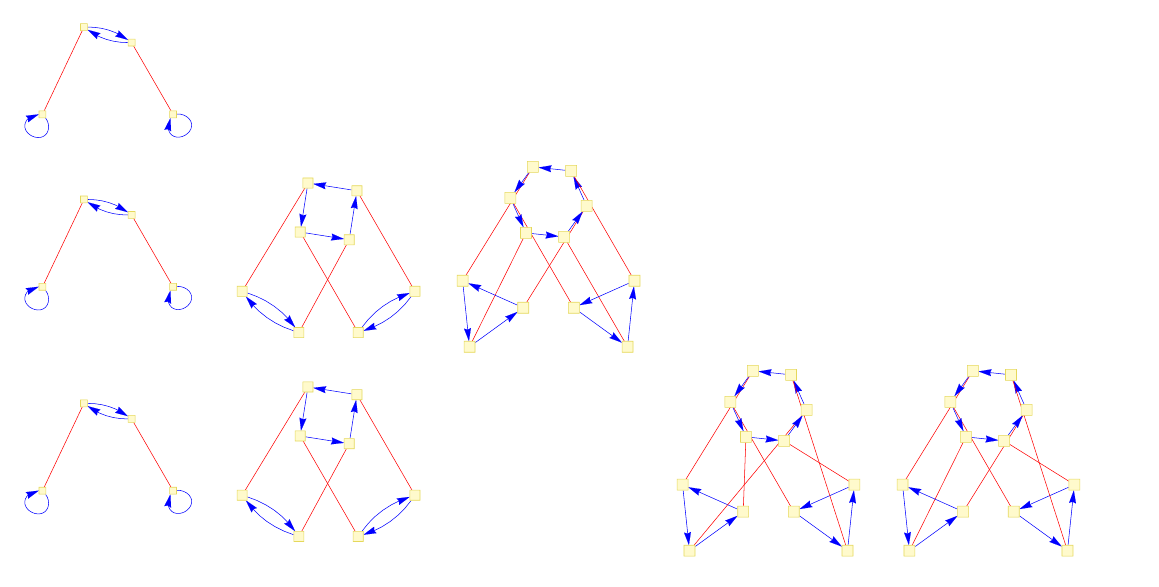
Figure 14 . Skeleton graphs of ( G 3 ) connected (6 ; 3 ; 3).